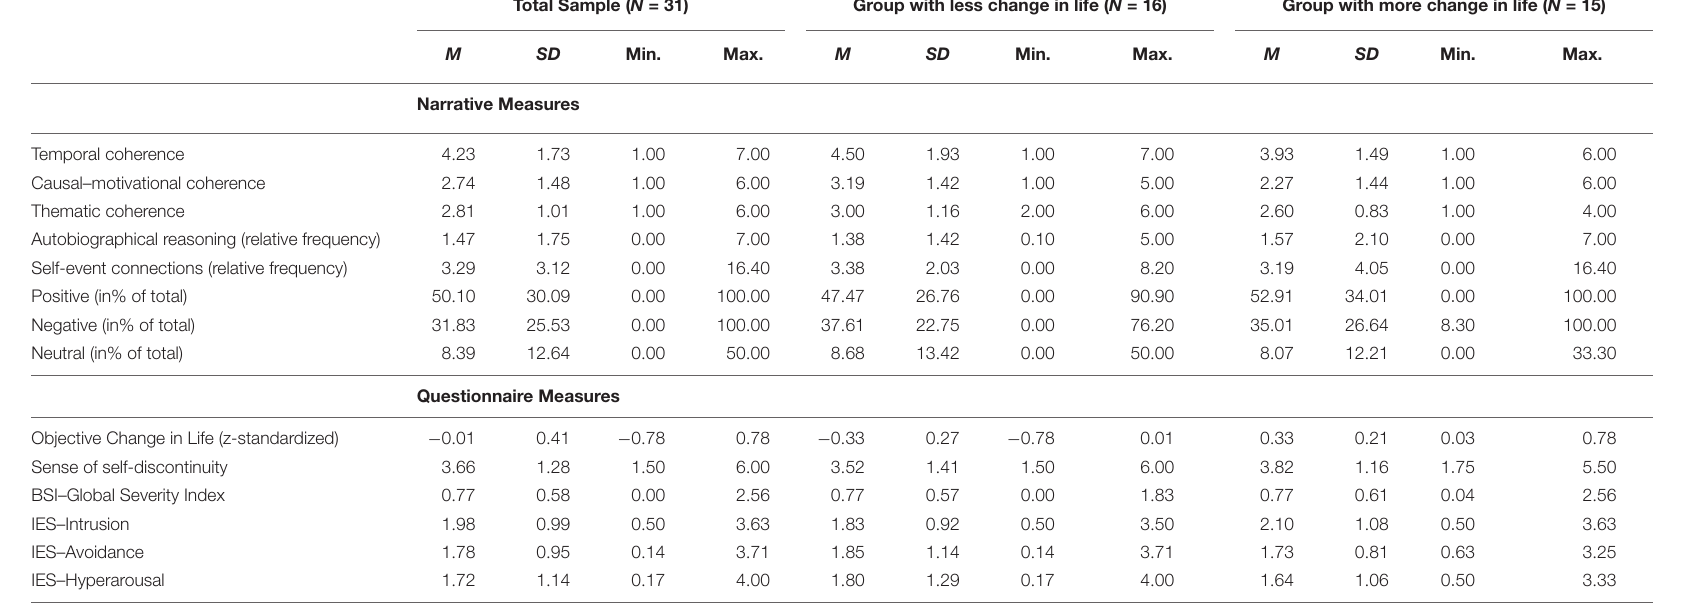
TABLE 3 | Mean, standard deviation, and range of narrative and questionnaire measures. Total Sample ( N = 31) Group with less change in life ( N = 16) Group with more change in life ( N =